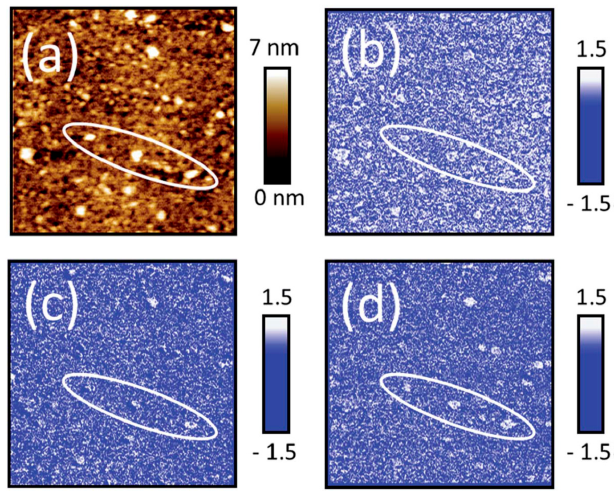
Figure 10. ( a ) Atomic force microscopy (AFM) topography image, amplitude images at